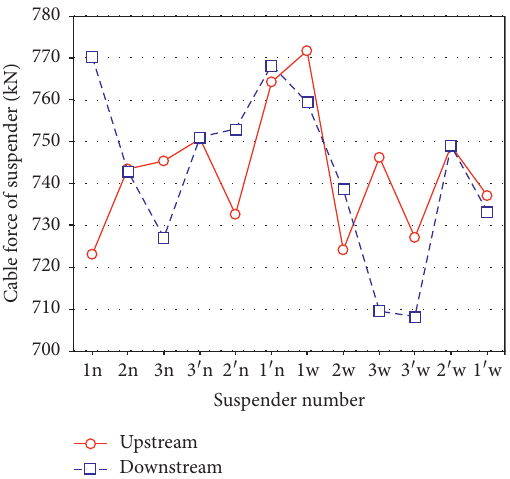
Figure 23: Cable force of short suspender after correction.